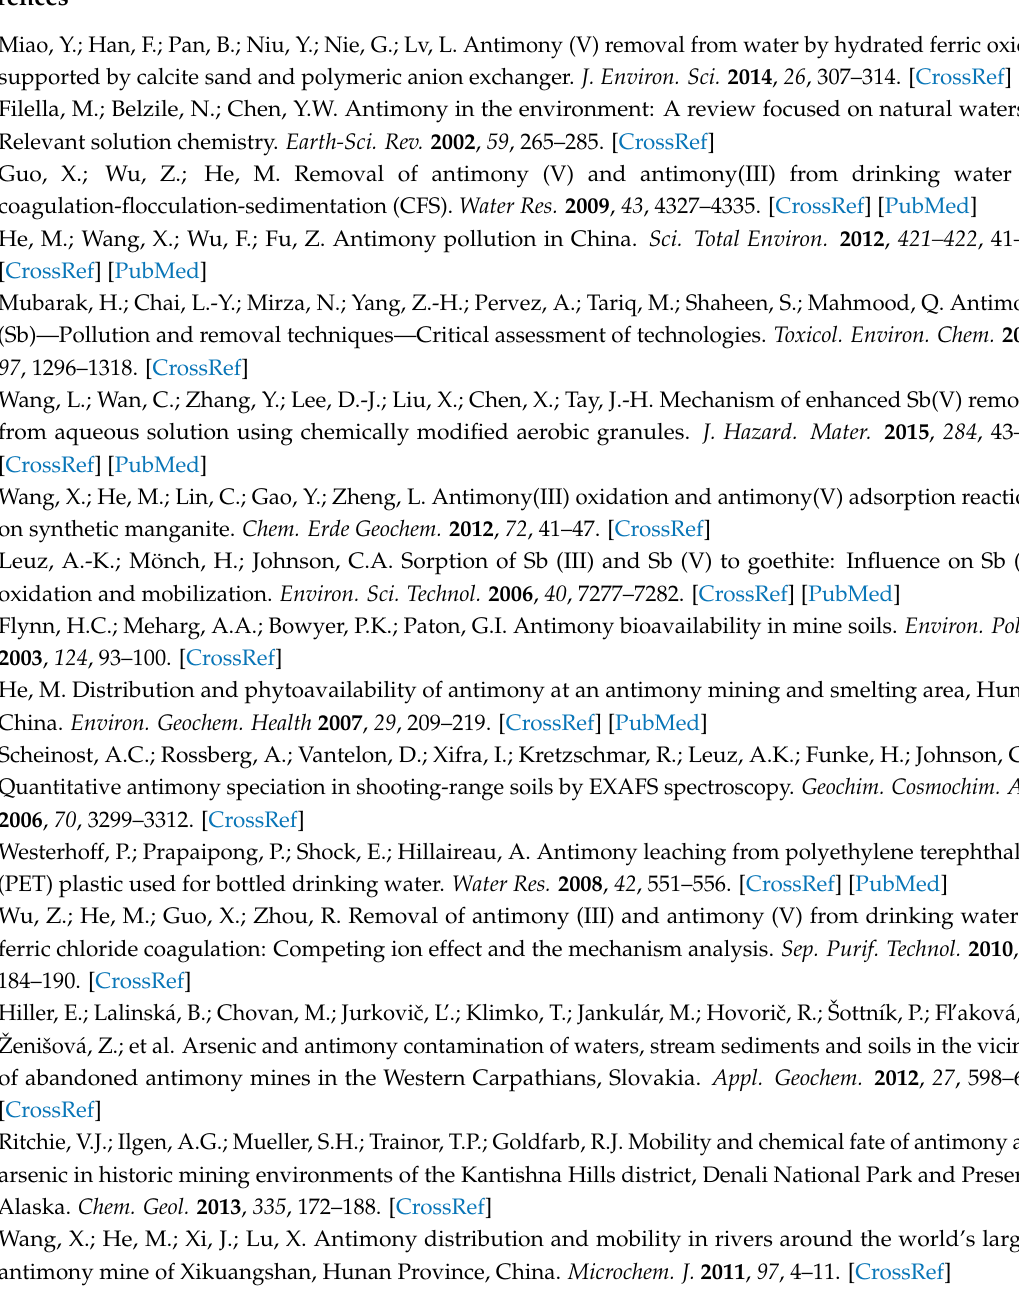
Figure S1: Speciation of ( A ) Fe(III); ( B ) Sb(III); ( C ) Sb(V) in water at 25 ◦ C. Diagrams derived by Visual